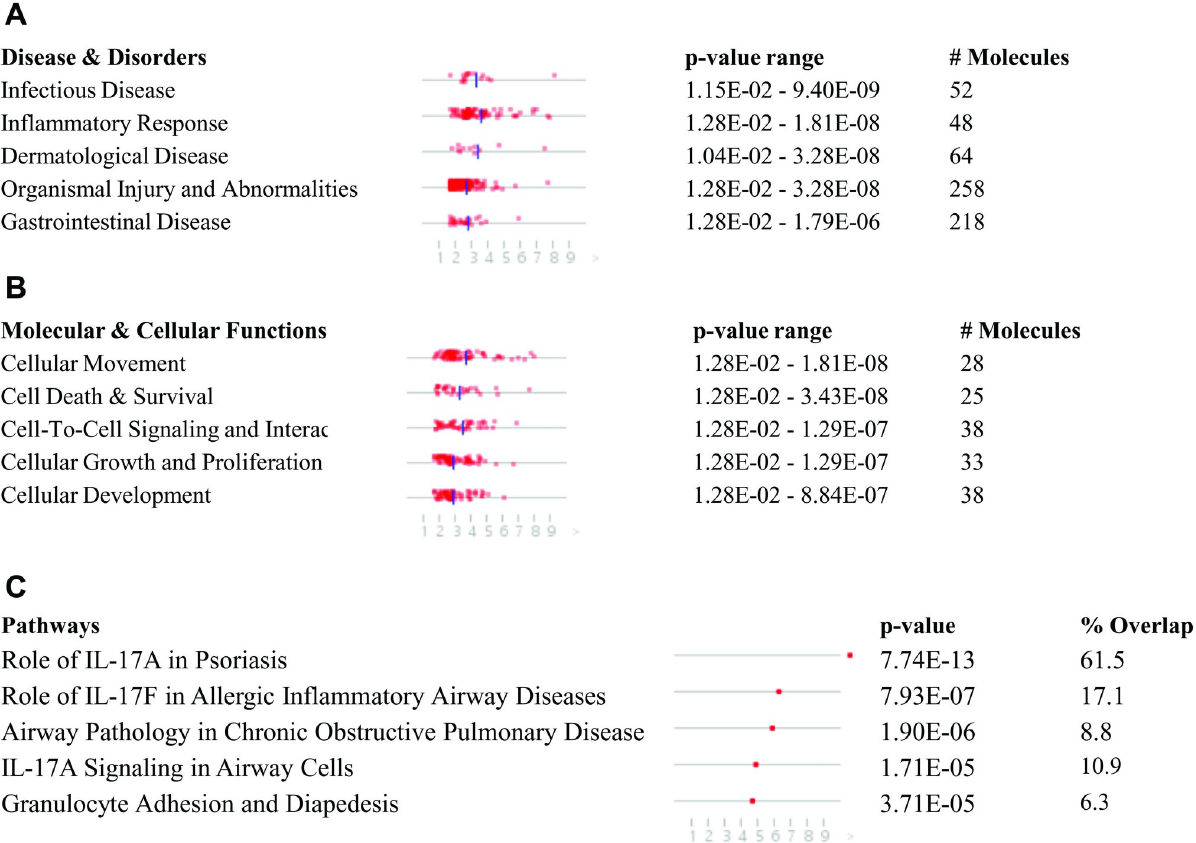
Fig 2. List of top 5 (A) disease and disorders, (B) cellular and molecular functions, and (C) canonical pathways that were enriched in the meta- analysis of three RNA-sequencing assays associated with SARS-CoV-2 infected ( in vitro ) airway epithelium.